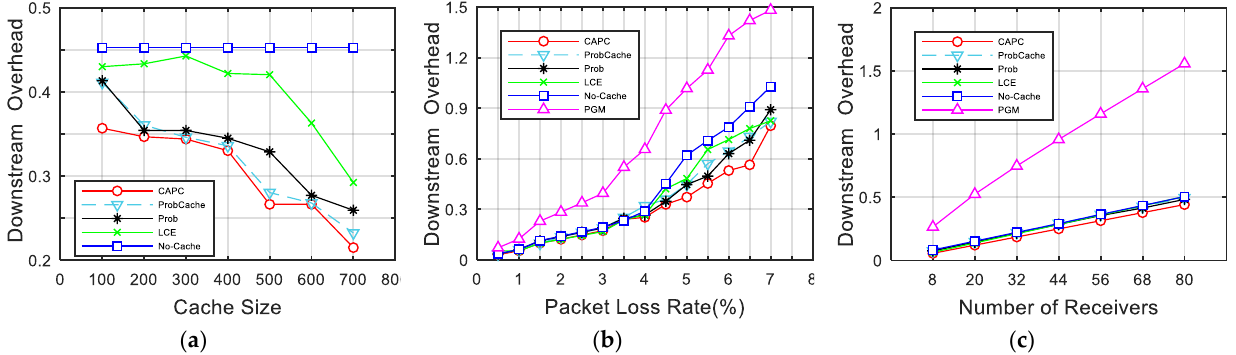
Figure 11. The comparison of downstream overhead. ( a ) The comparison of downstream overhead under different cache sizes; ( b ) the comparison of downstream overhead under different packet loss rates; ( c ) the comparison of downstream overhead under different numbers of receivers.